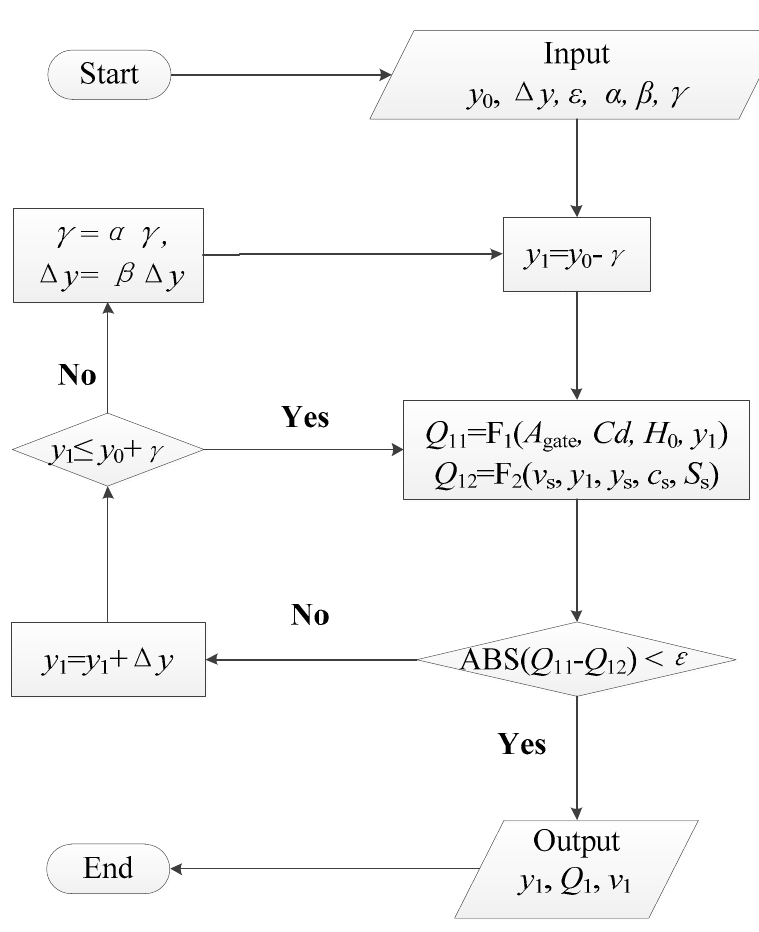
Figure 11. Logical flow chart of the double forward method (DFM).